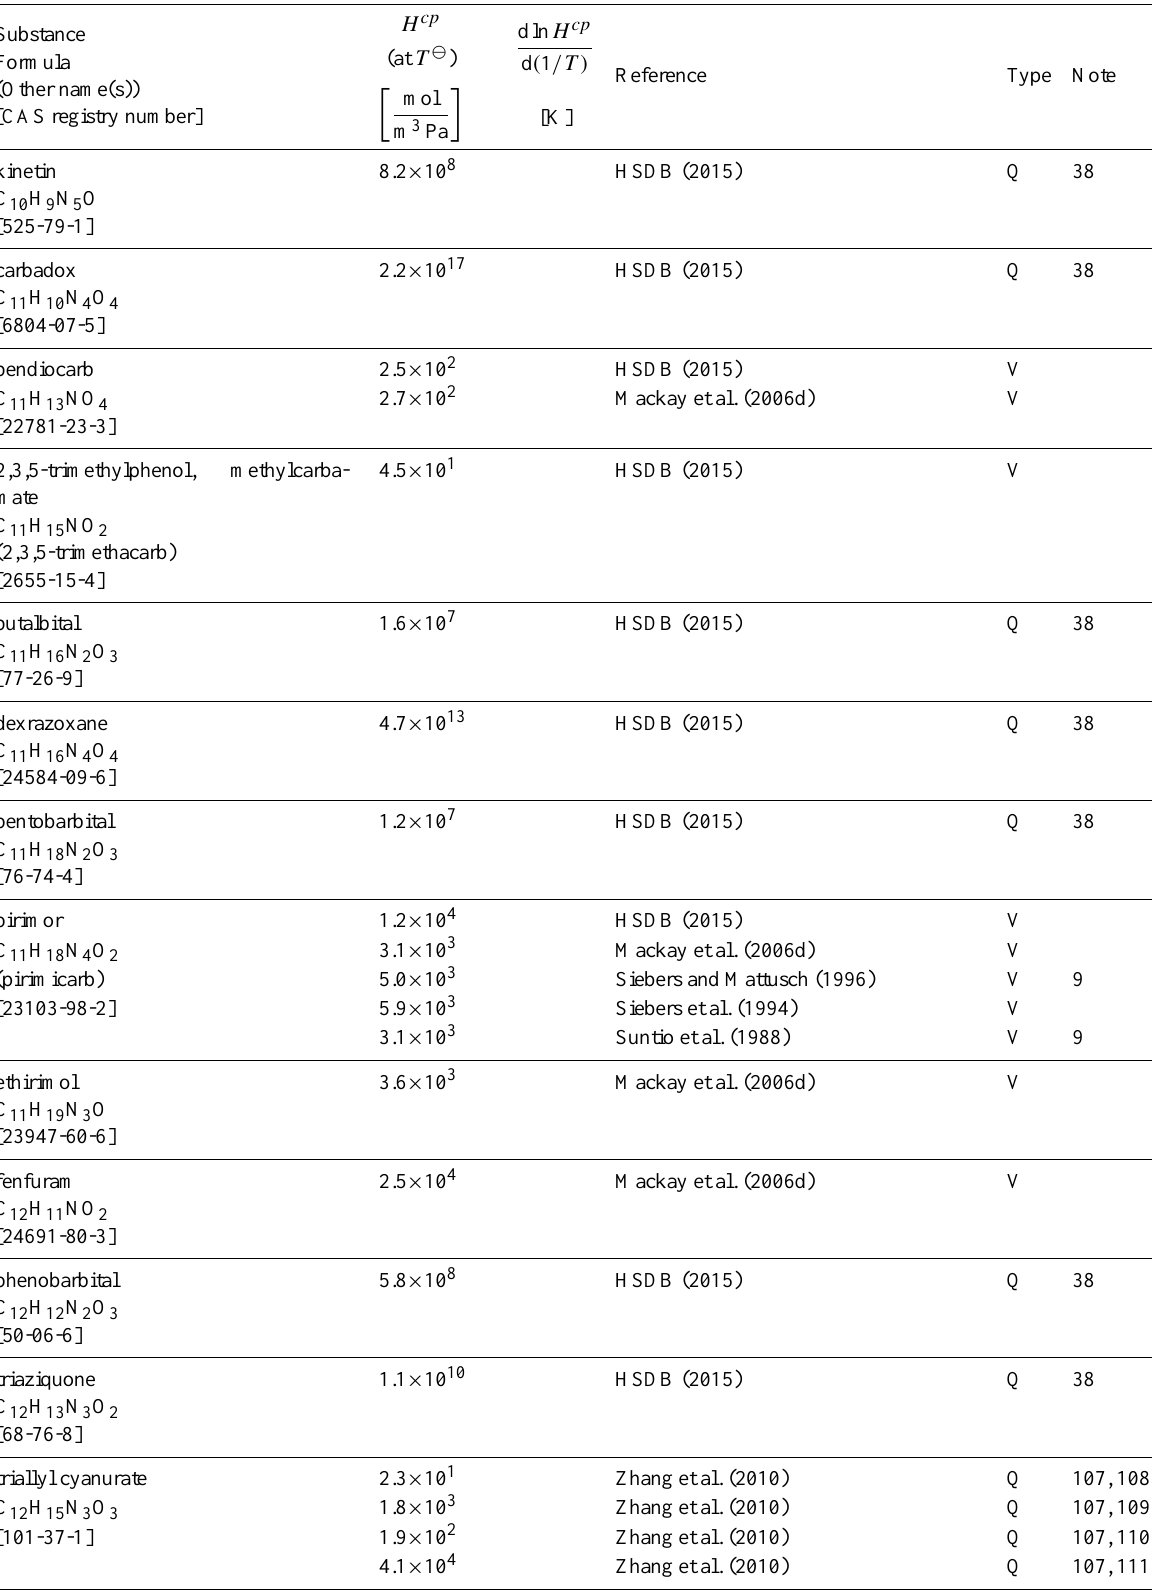
Table 6: Henry’s law constants for water as solvent